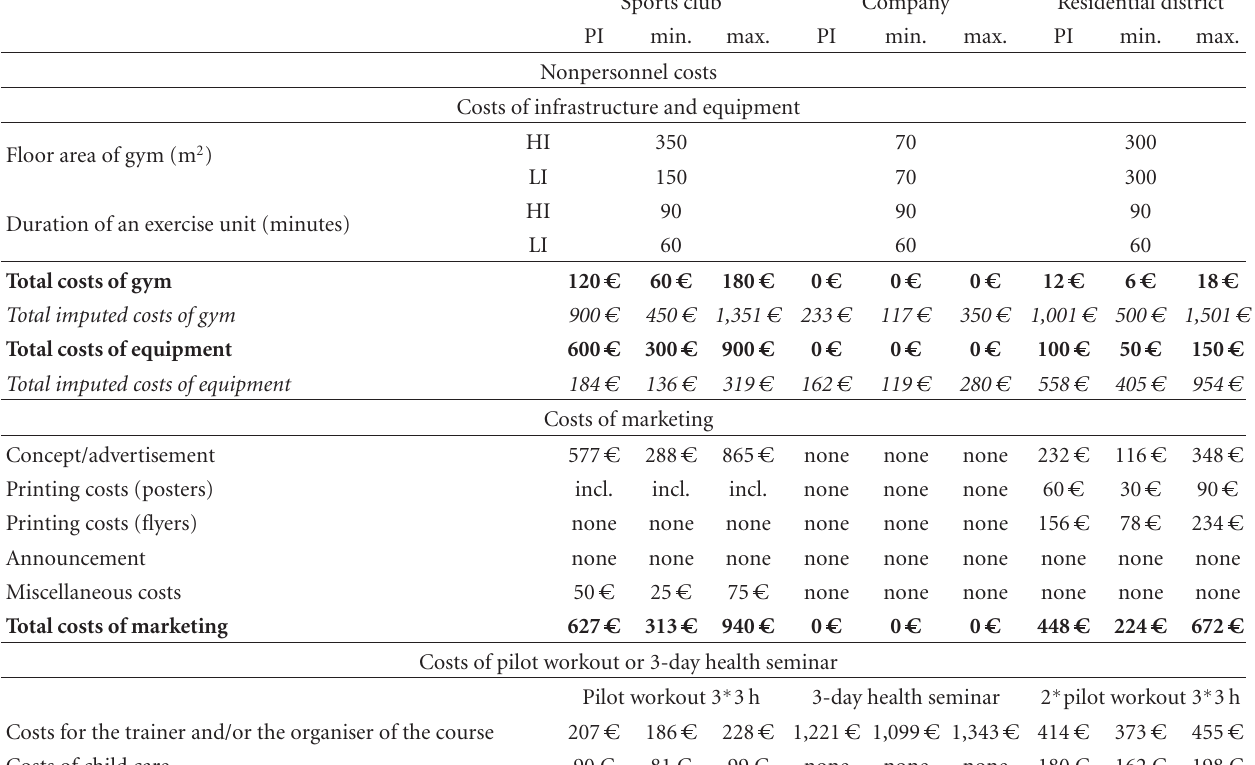
Table 4: Resource use and total cost of programme implementation (without inputs provided by the scientific team) by setting, types of activity, and input/cost